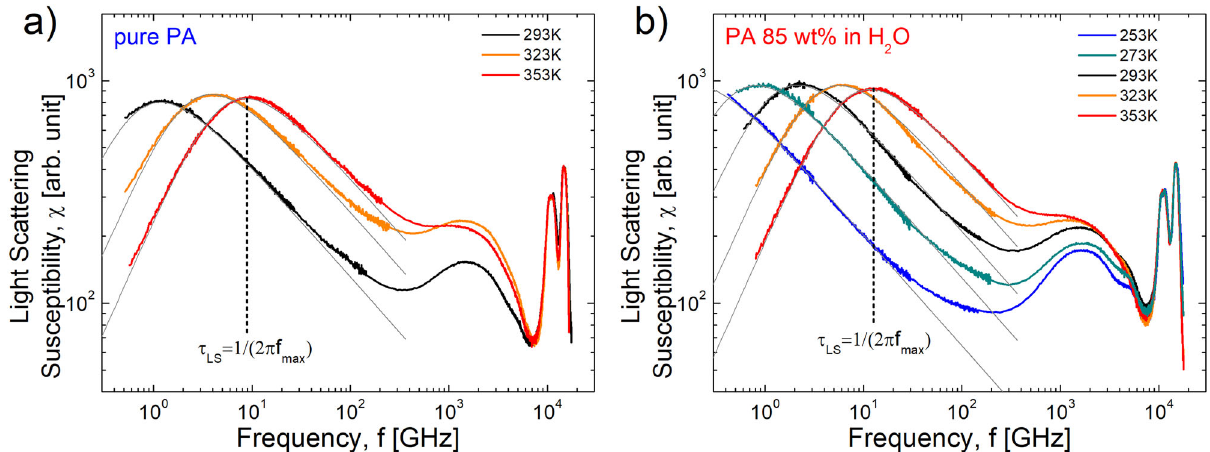
Fig. 4 Light scattering susceptibility spectra. Light scattering susceptibility spectra for a pure PA and b PA85. High frequency Raman modes were used to normalize the spectra at different temperatures. Gray line is the Cole-Davidson fi t function 70 . The relaxation time was estimated from the maximum relaxation peak, τ LS = 1/2 π f max .